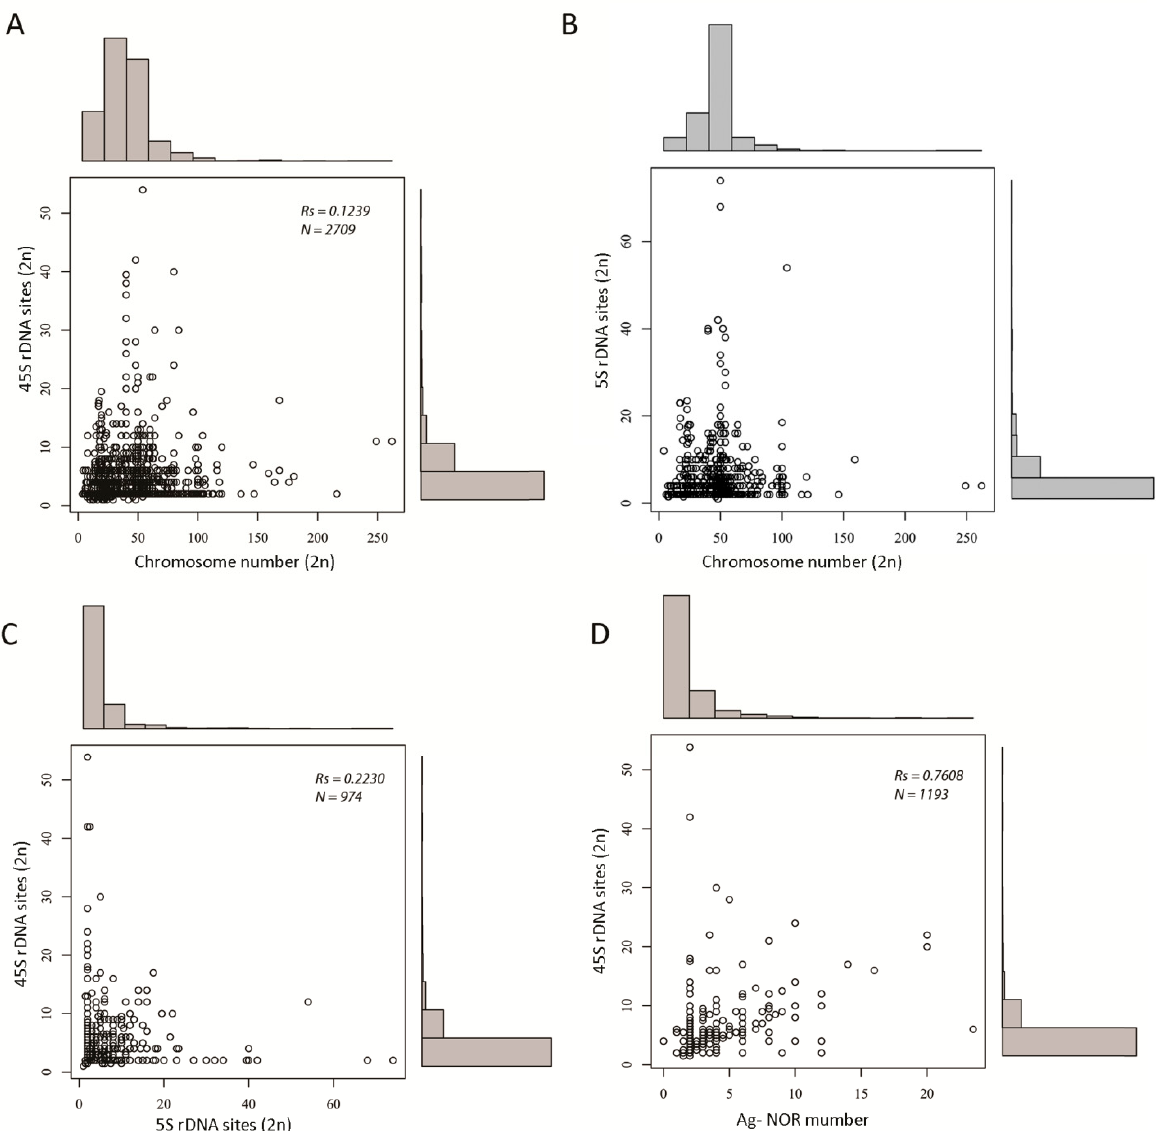
Figure 3. Scatter graphs showing relationships between rDNA locus number and other variables including chromosome number and number of Ag-NOR signals. ( A ) A plot of 45S rDNA and chromosome number. ( B ) The same as in ( A ) but for 5S rDNA. ( C ) A plot of 5S and 45S rDNA numbers. ( D ) A plot of the number of Ag-NOR signals and number of 45S rDNA loci. Legend: Rs, Spearman’s correlation coefficient; N, number of data points. Details of statistical tests are in Table S2.